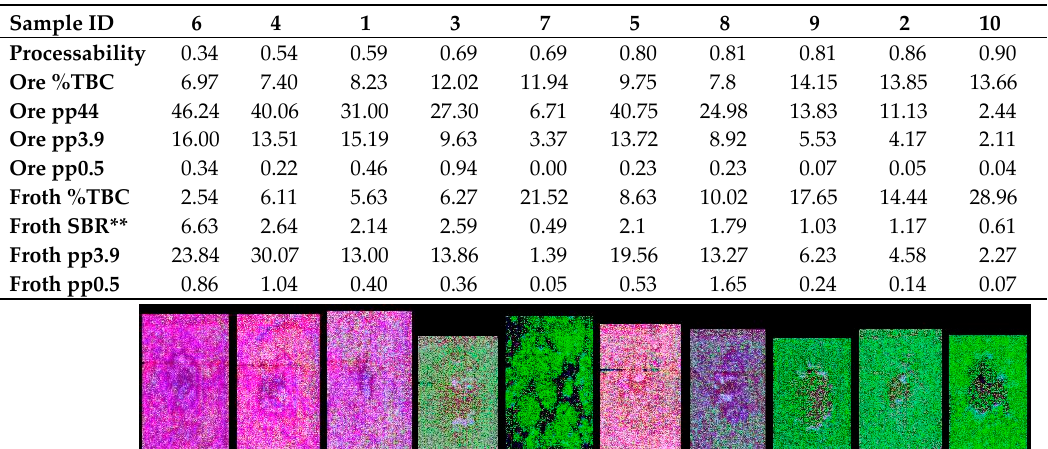
Figure 5. Time series of hyperspectral imagery of froth for Sp#2, 4, and 6, shown as a color composite of 1.2 µ m (red), 1.9 µ m (green), and 2.3 µ m (blue). Froth rich in bitumen is darker green. Imagery is shown at 30 s, 5 min, and 10 min after the removal of the impeller (leaving circular opening in center of froth surface). Total bitumen content (TBC) and processability (Proc.) are listed for each sample. Table 3. Processability, ore, and froth characteristics of the first sample suite along with the imagery of froth *. Samples are listed in order of increasing processability.